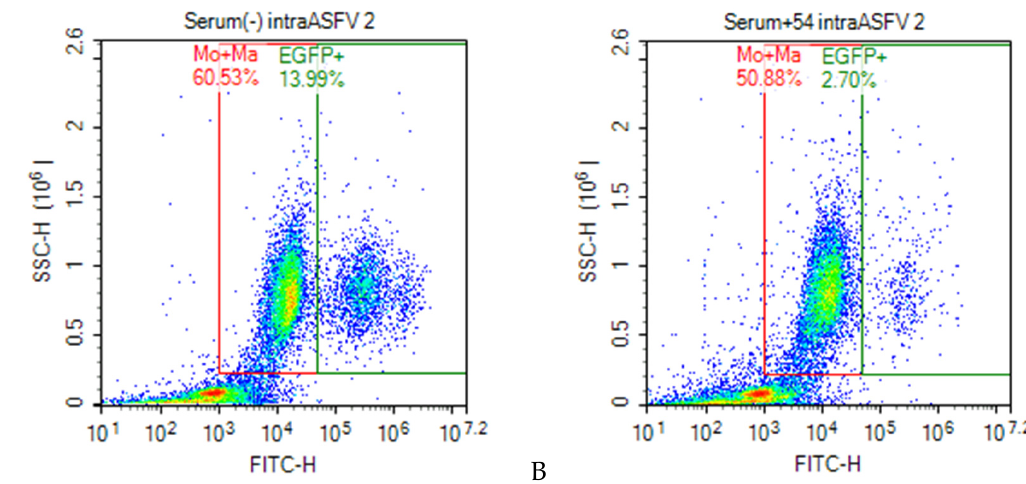
Figure 3. The cell distribution on the SSC vs. FITC (EGFP signal) plot of adherent PBMC gated on monocytes and macrophages (red) and EGFP+ cells (green) after infection with ASFV at MOI of 0.5 HAD 50 treated with ( A ) naïve serum ( − ) and ( B ) hyperimmune serum (+).